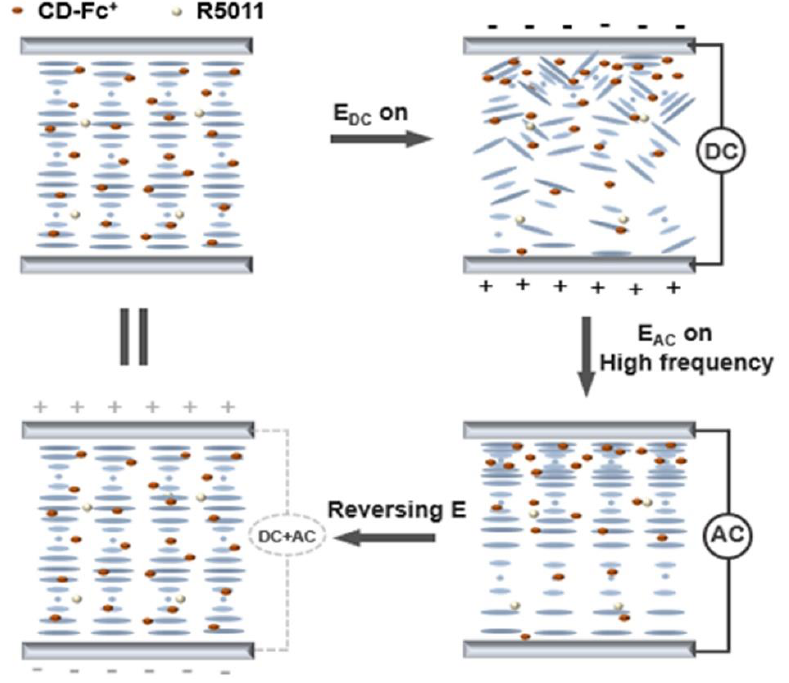
Figure 2. Schematic of reflection bandwidth of electronically controlled